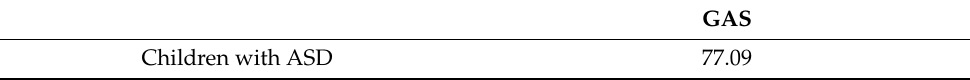
Table 2. Average value of T of the GAS method for evaluating child–robot interaction.